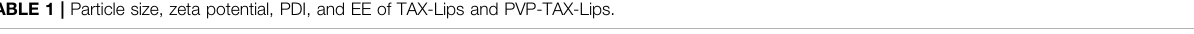
TABLE 1 | Particle size, zeta potential, PDI, and EE of TAX-Lips and PVP-TAX-Lips. Group